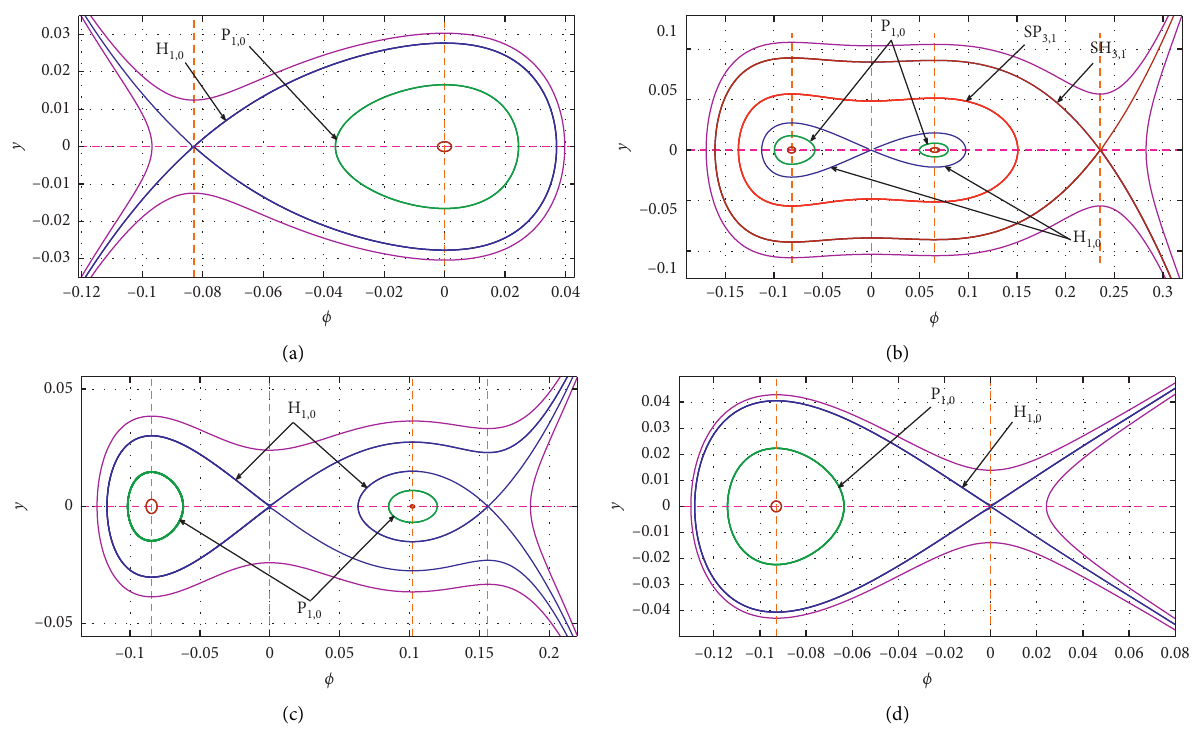
� 0 . 01, n � 0 . 99, n � 0 . 05, n � 0 . 9, σ � 0 . 0025, σ � 0 . 4, b 0 e 0 i 0 p 0 b i